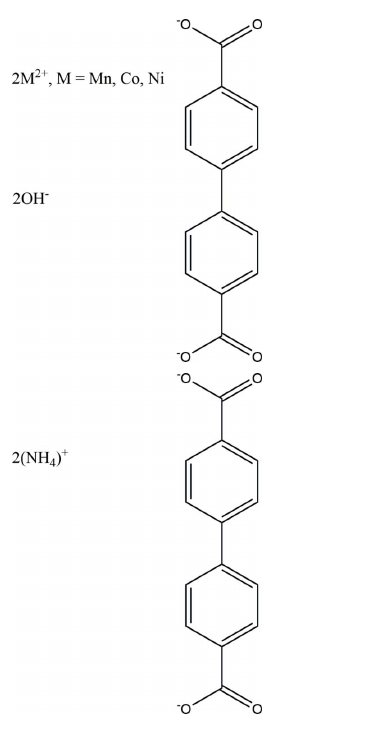
Figure 3 Powder patterns of Mn 2 BPDC(OH) 2 (calculated from CSD entry UBUPEQ; red) to the experimental patterns of Co2BPDC(OH)2 (green) and Ni 2 BPDC(OH) 2 (black). The patterns were converted to Cu K (cid:3) using JADE Pro (MDI, 2021). Image generated using JADE Pro (MDI,